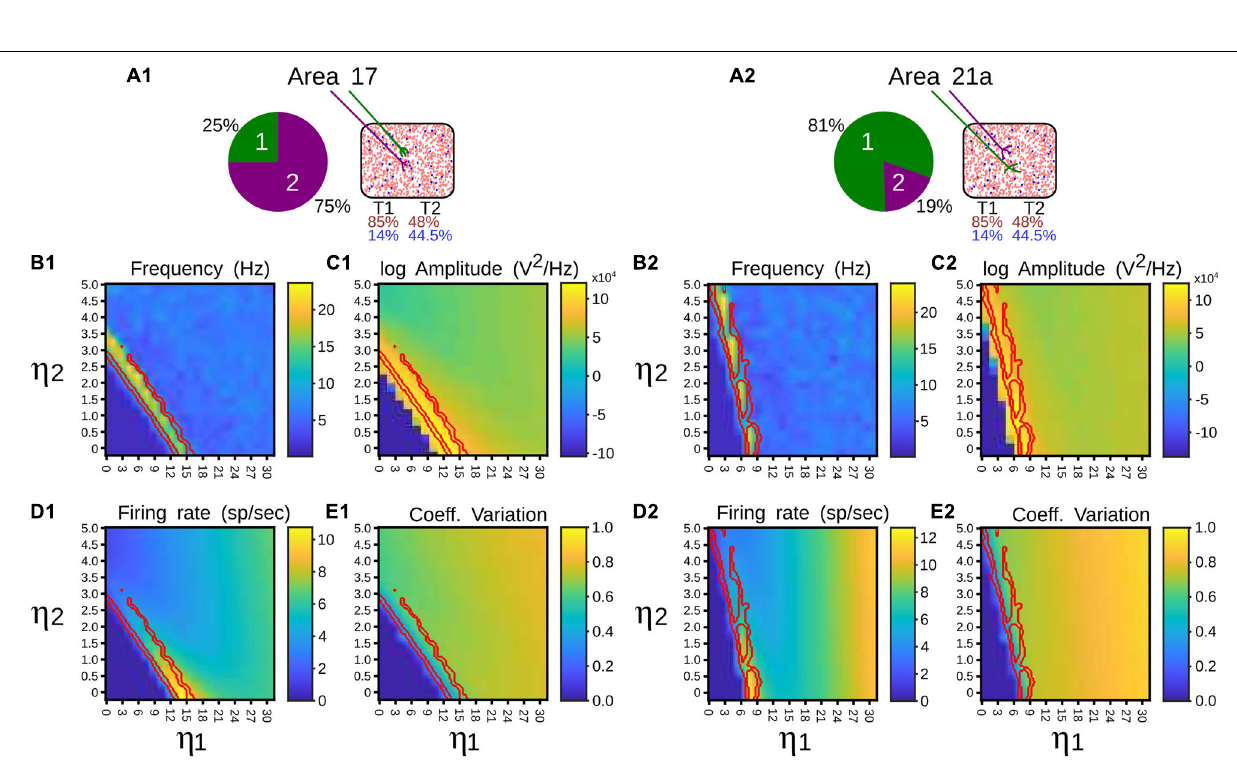
FIGURE 4 | Quantitative outputs for a pulvinar network whose neurons receive terminal types 1 (1) and 2 (2) as input, and connection weights increase gradually. Factors η